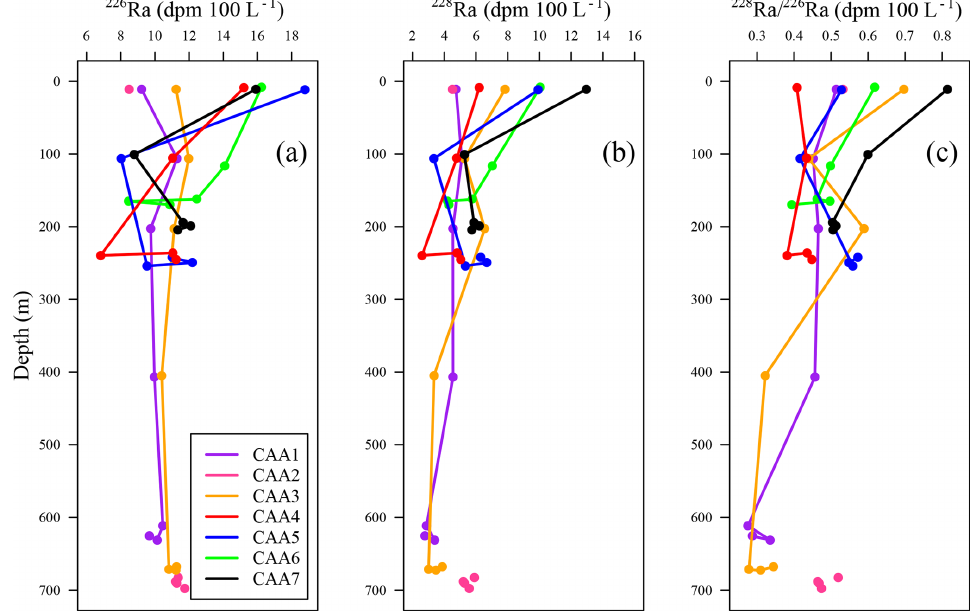
Figure 3. (a) 226 Ra, (b) 228 Ra, and (c) 228 Ra / 226 Ra profiles ranging from the surface to depth for stations CAA1 to CAA7 (where pink dots indicate station CAA2, which was only sampled at the surface and bottom) throughout the Canadian Arctic